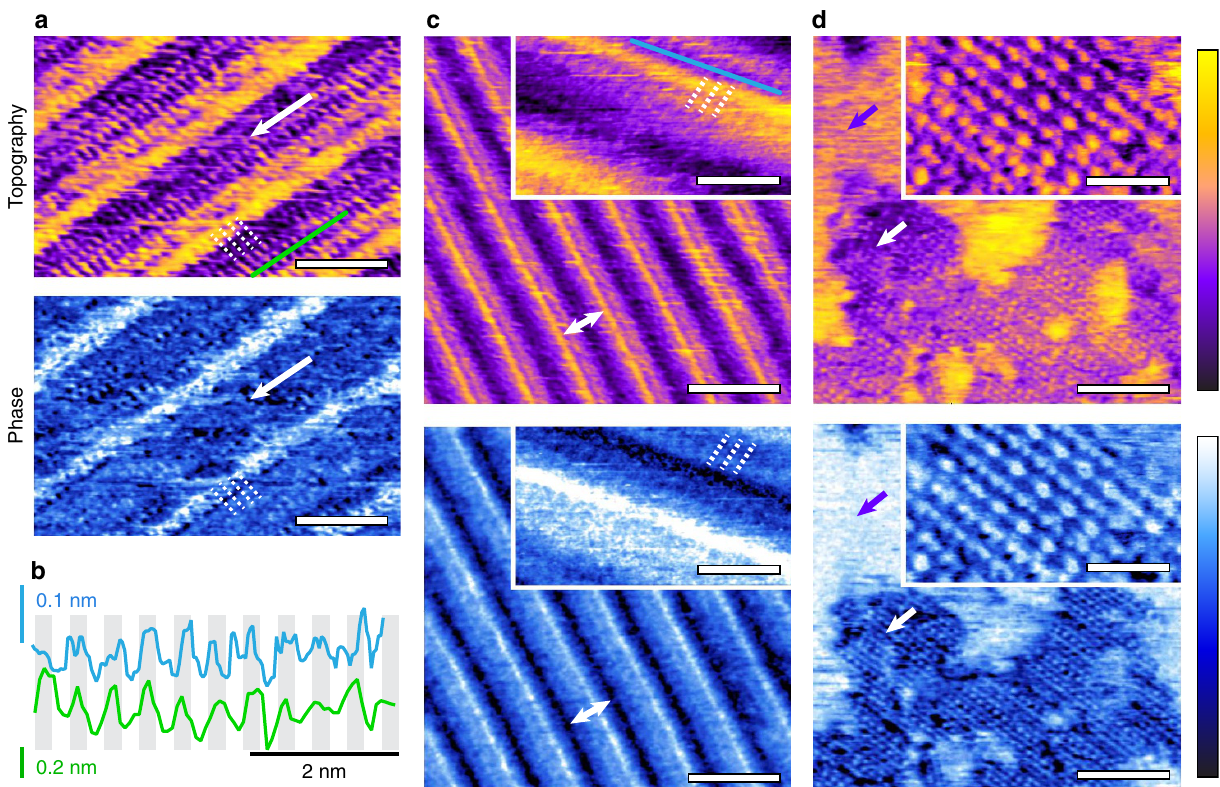
Figure 1 | High-resolution AM-AFM imaging of the HOPG–liquid interface. ( a ) Regular array of longitudinal rows (white arrow) obtained in a 1:1 water- MeOH mixture spiked with o 1% EtOH. Each row is composed of several B 5Å wide sub-rows running in parallel, and epitaxially following the underlying HOPG lattice (Supplementary Fig. 3). Finer structure with 6.1 ± 0.2Å periodicity can also be seen perpendicular to the rows (dotted white lines), as evidenced by the green profile in ( b ) where the periodicity is highlighted. ( c ) A similar row-like structure is visible in a 1:1 water-MeOH solution without any EtOH. The inter-row distance (white arrow) is 58 ± 2Å. Magnification over a set of row (inset) shows a 5.9 ± 0.6 periodicity perpendicular to the rows (dotted white lines), but less marked than in ( a ). A profile taken along the row (blue in b ) confirms the finer structure although with an amplitude B 4 times less marked than for ( a ). The clearer resolution with EtOH may be due to the slightly larger periodicity making the difference close to the resolution limit for this system. The structures could be observed with different cantilevers and types of AFM. At low ( B 5%) MeOH concentration ( d ), other 2D structures can be observed forming islands (white arrow) in an otherwise unstructured interface (purple arrow). These structures require a higher temperature to nucleate. Magnification over these assemblies (inset) shows a network of protrusions organized in alternated rows. Along a row, the distance between the smaller protrusions is B 5.5Å and between the larger protrusions is B 11Å. The distance between adjacent rows is B 6.3Å. The assemblies tend to exhibit a high degree of polymorphism at the molecular level (Supplementary Fig. 2). The scale bars are 20Å (a), 100Å ( c , d ), 30Å ( c , d , inset). The purple colour scale bar represents topographic variations of 8Å ( a ), 8Å ( c ), 5Å ( c , inset), 12Å ( d ), and 7Å ( d , inset). The blue scale bar represent a phase variation of 15 (cid:2) ( a ), 12 (cid:2) ( c ), 10 (cid:2) ( c , inset), 13 (cid:2) ( d ), and 16 (cid:2) ( d , inset). The temperature is 36 ± 3 (cid:2) C ( a – c ) and 60 ± 0.1 (cid:2) C ( d We performed simulations using a super-cell geometry comprising eight graphite layers aligned along the xy plane and separated by the MeOH-water mixture. The simulation cell included about 40,000 atoms (Fig. 2a). Simulations were performed for five different X MeOH compositions, and at constant temperature and pressure, leaving only the z direction free to fluctuate.